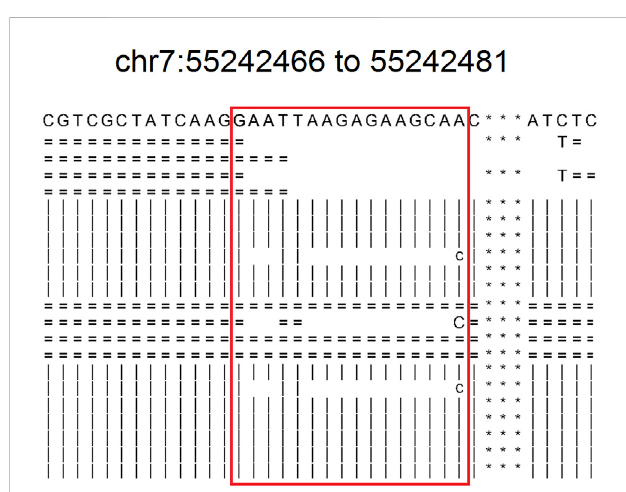
FIGURE 4 The readsmapping of one complexmutation. The sites in the red boxrepresentsfrom55242466 to55242481 ofchr7. “ = ” indicatesthatit isidentical to thereference base inthepositive strand. “ | ” indicatesthat it isidenticaltothereferencebaseinthenegativestrand. “ c ” indicates negative strandmismatch. “ C ” indicates positive strand mismatch. Blank indicates